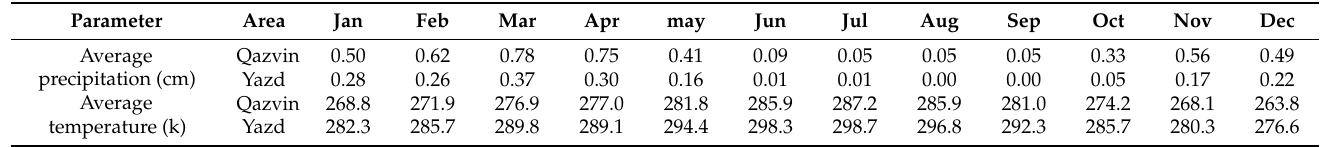
Table 1. Monthly average of precipitation and temperature from 1979 to